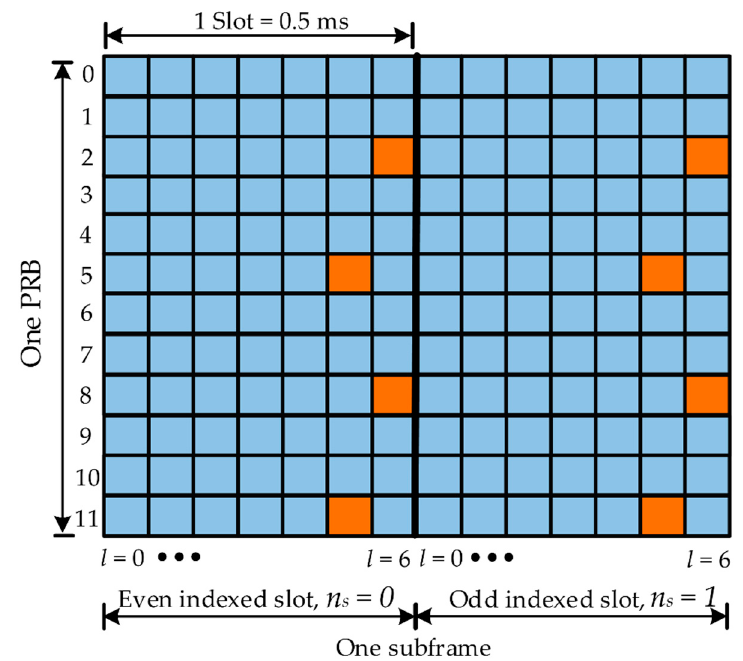
Figure 4. NRS mapping for a single antenna port.